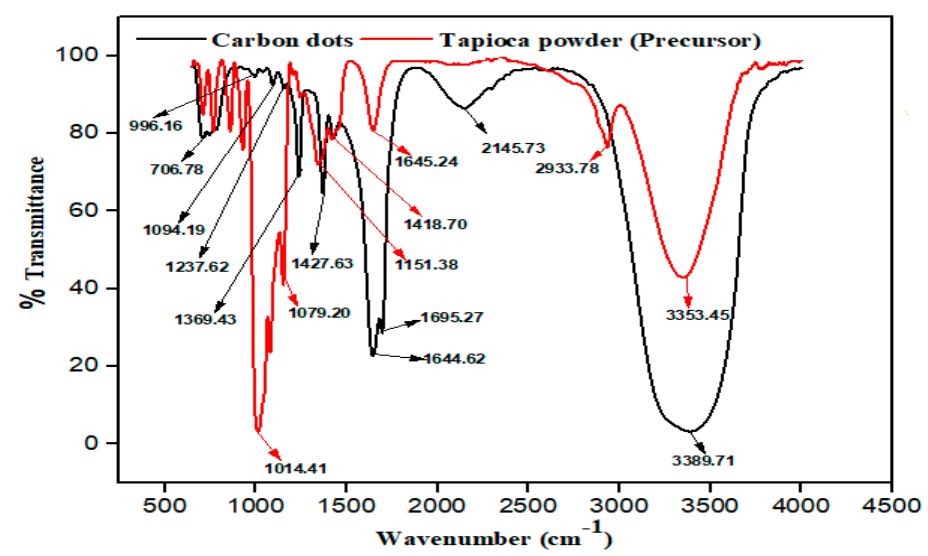
Figure 5. Fourier-transform infrared spectroscopy (FT-IR) spectrum of CDs and tapioca.